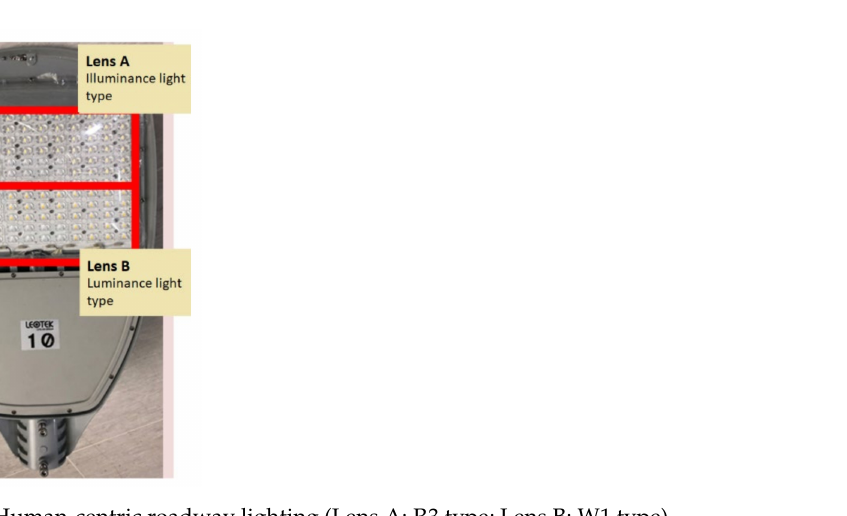
Figure 14. Human-centric roadway lighting (Lens A: R3 type; Lens B: W1 type).